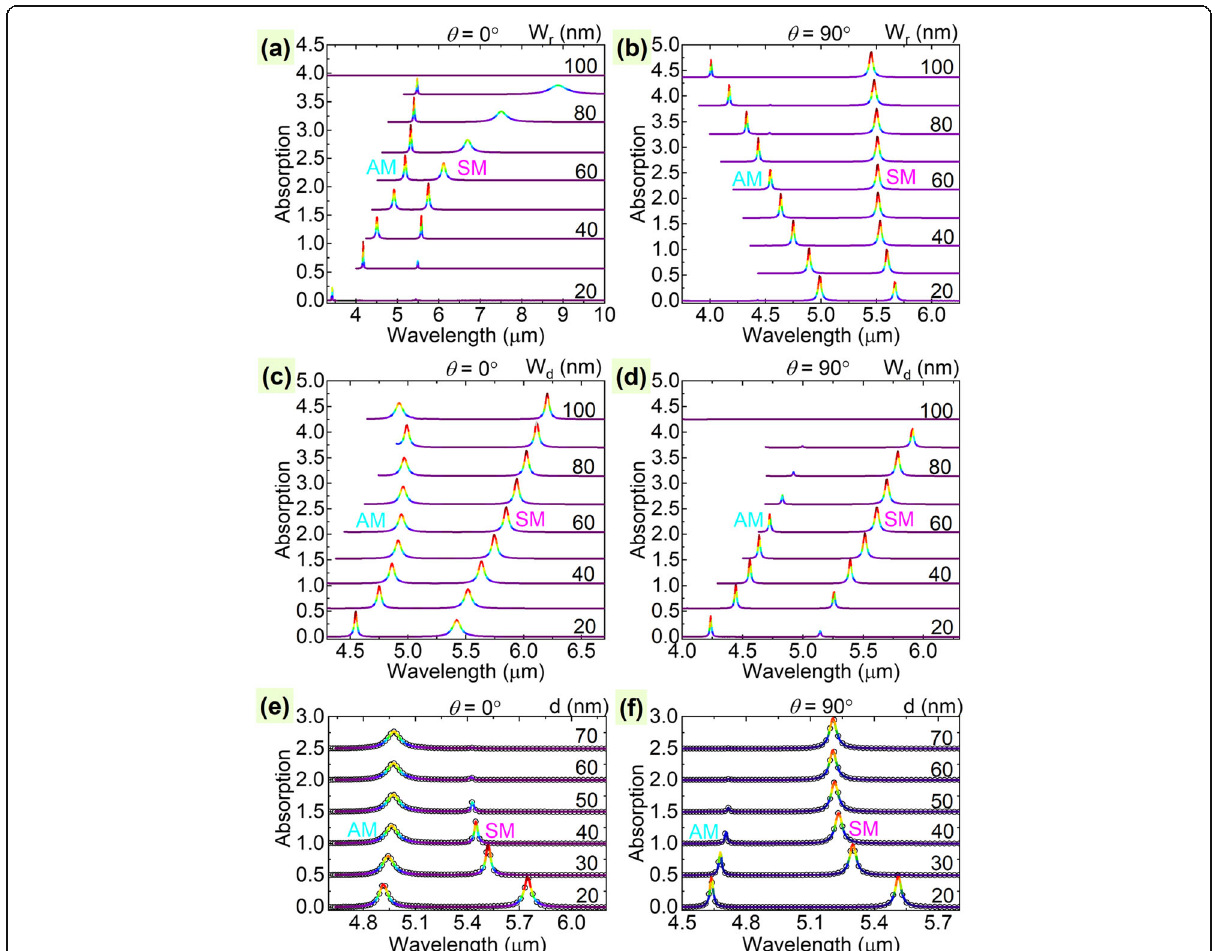
Fig. 3 Absorption spectra of the PIT system in the wavelength scale as functions of ( a ), ( b ) the ribbon width W r of LGNRs; ( c , d ) the DG width W d of UGGs; and ( e , f ) the separation distance d between the two graphene layers with a step of 10/20 nm at polarization angles of θ = 0° ( a , c , e ) and 90° ( b , d , f ), respectively. In ( a – f ), the deeper red color in the solid lines denotes a stronger absorption. Note that some of the lines are cut to avoid distractions from other higher-ordered absorption peaks. In ( e ) and ( f ), solid curves and dark circles present the numerical and theoretical results, respectively. SM and AM refer to the symmetric mode and antisymmetric mode,